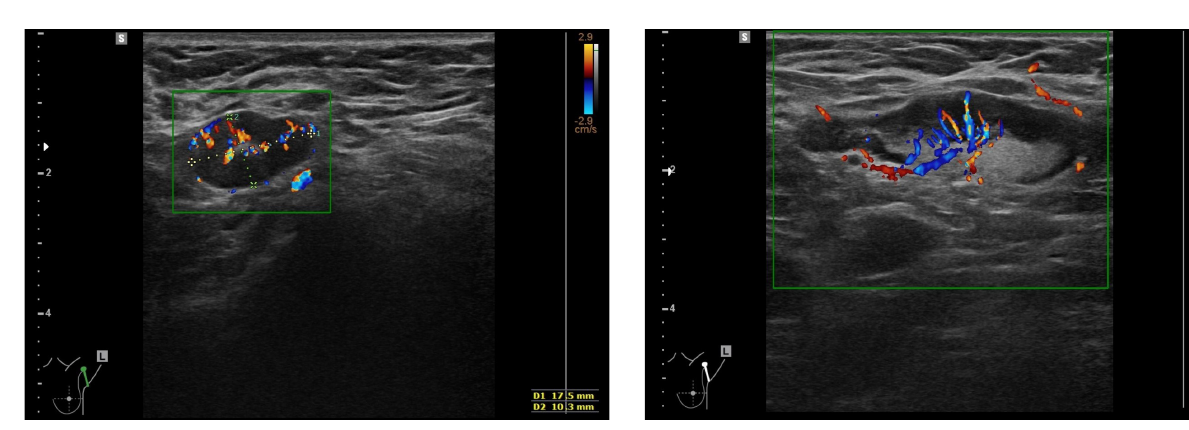
Fig. 4. Metastatic lymph node with diffuse cortex thickening and irregularly distributed cortex (verified by core biopsy).